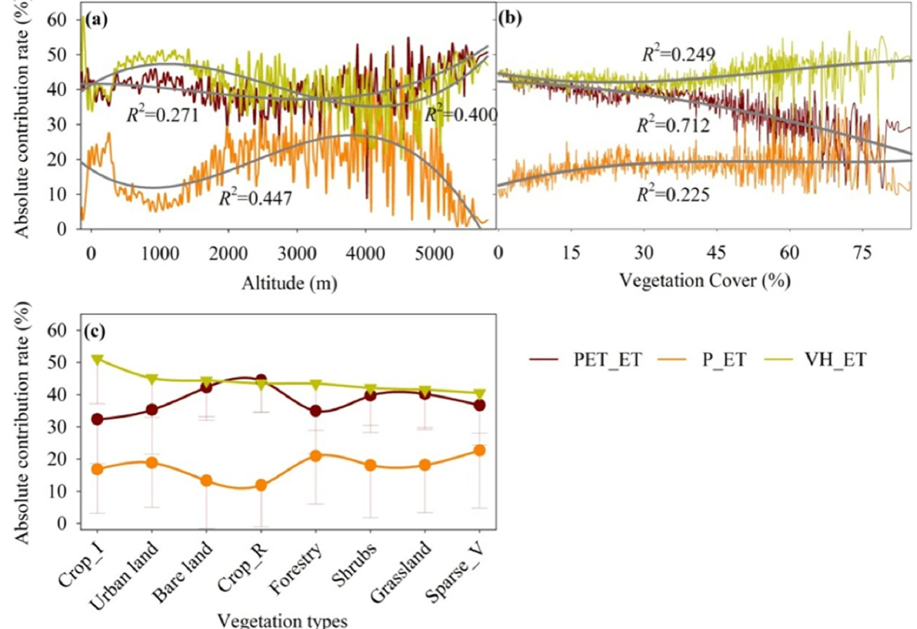
Figure 4. Changing trend of absolute contribution rates of annual PET , P , and VH to ET along alti- tude ( a ) and vegetation cover ( b ) grades, and that in different vegetation types ( c ). In panel ( c ), the